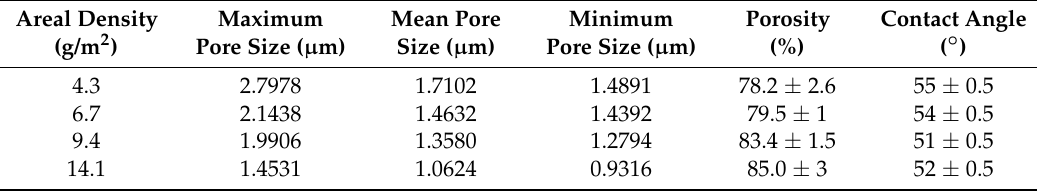
Table 3. Pore size, porosity and contact angle of different areal density